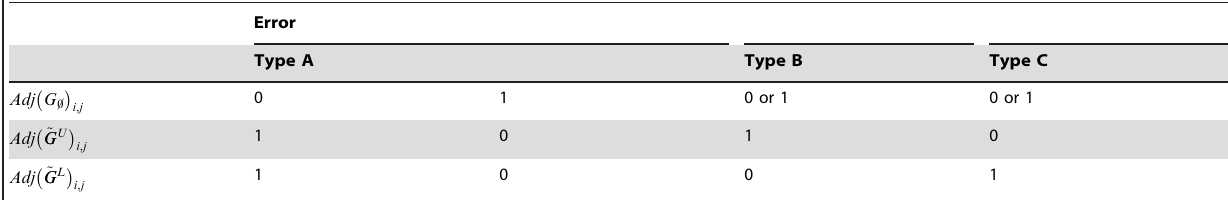
Table 1. Types of Errors in ~ GG L and ~ GG U